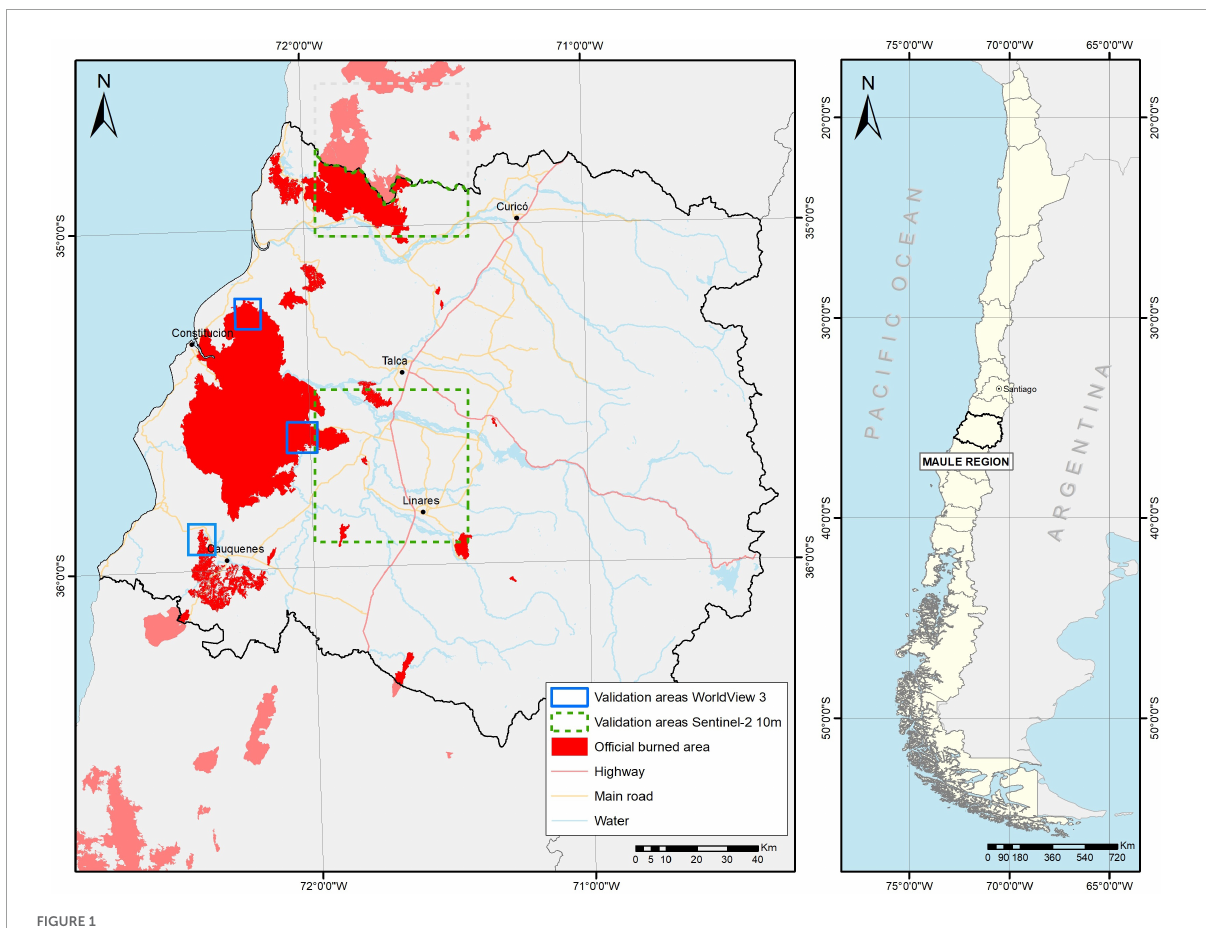
FIGURE1 Location of the study area: Región del Maule,